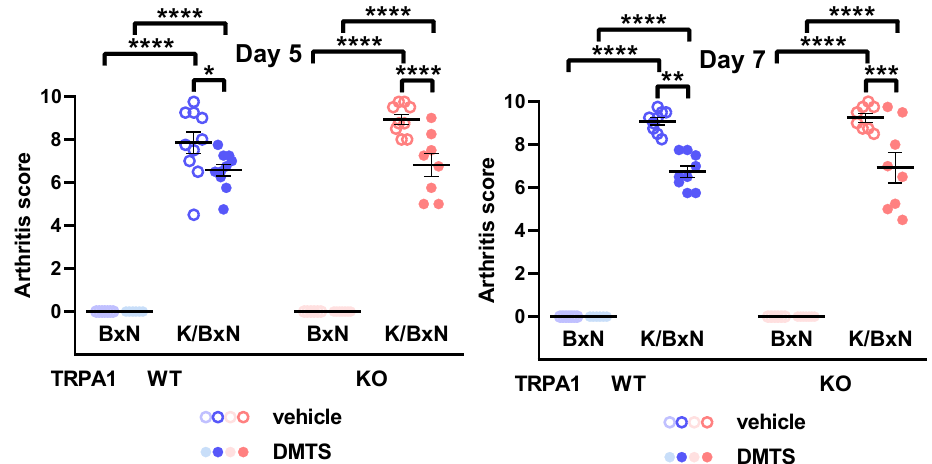
Figure 3. DMTS treatment reduced arthritis score of TRPA1 WT and KO mice 5 and 7 days after the administration of arthritogenic serum. The score represents swelling and redness of the hind paws, as well as passive mobility of the tibiotarsal joints. Symbols indicate individual data points. Open symbols represent vehicle-treated animals, while solid symbols illustrate DMTS-treated ones. Horizontal lines indicate mean and whiskers show SEM. One-way ANOVA and Holm-Sidak’s test: n = 6–10. * p < 0.05, ** p < 0.01, *** p < 0.001, **** p < 0.0001 vs. indicated group.